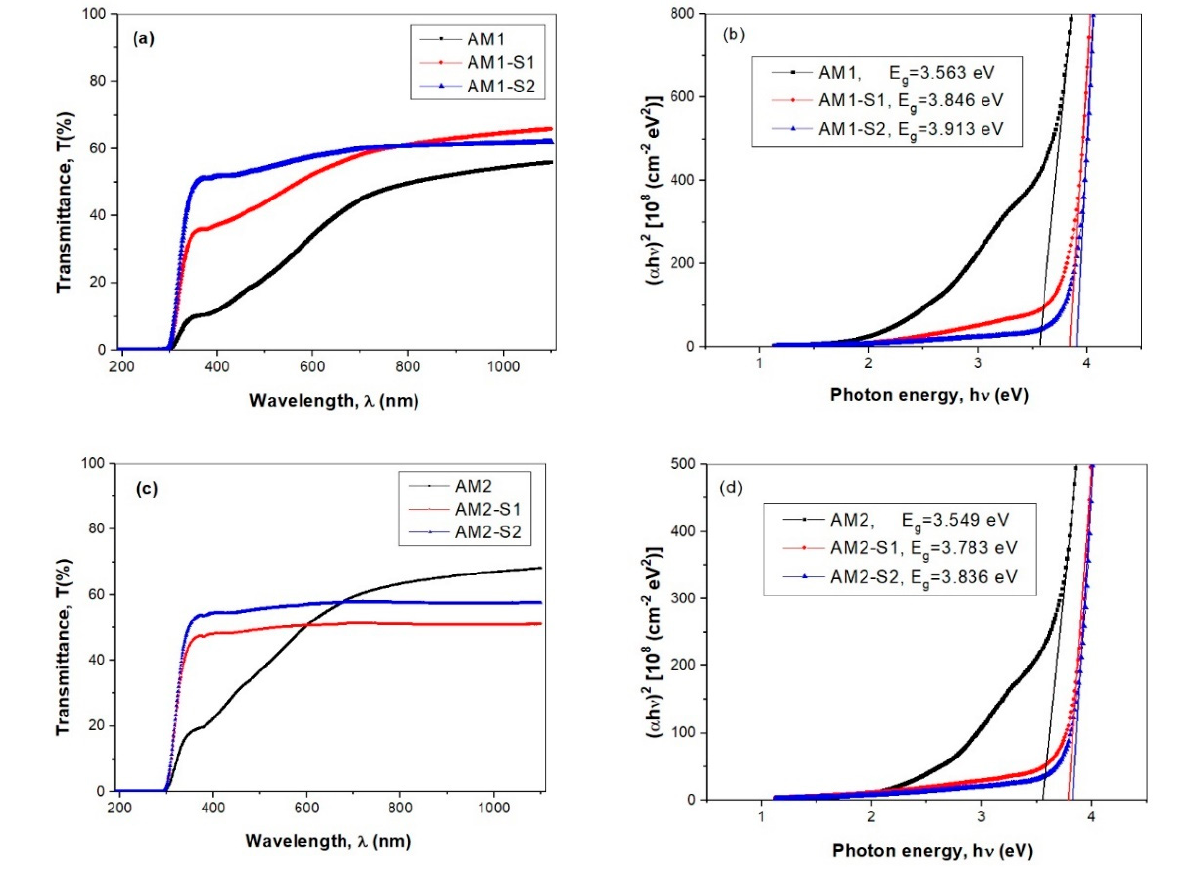
Figure 6. Optical transmittance spectra ( a , c ) and Tauc plots ( b , d ) of the simple iron oxide (M1 and M2), together with the corresponding core–shell silica modified (M1-S1/2 and M2-S1/2) thin films.